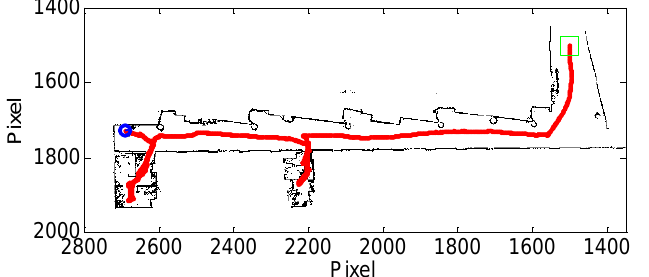
Figure 3. Final map of the facility: starting point (green square), robot path (red line) and ending point (blue